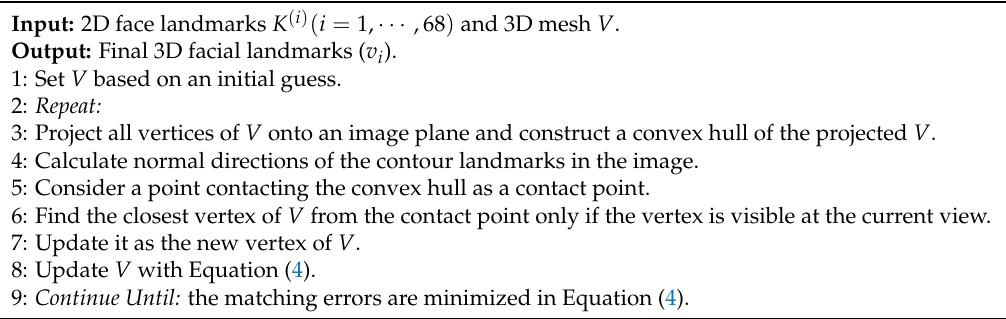
Algorithm 1 . Contour fitting algorithm